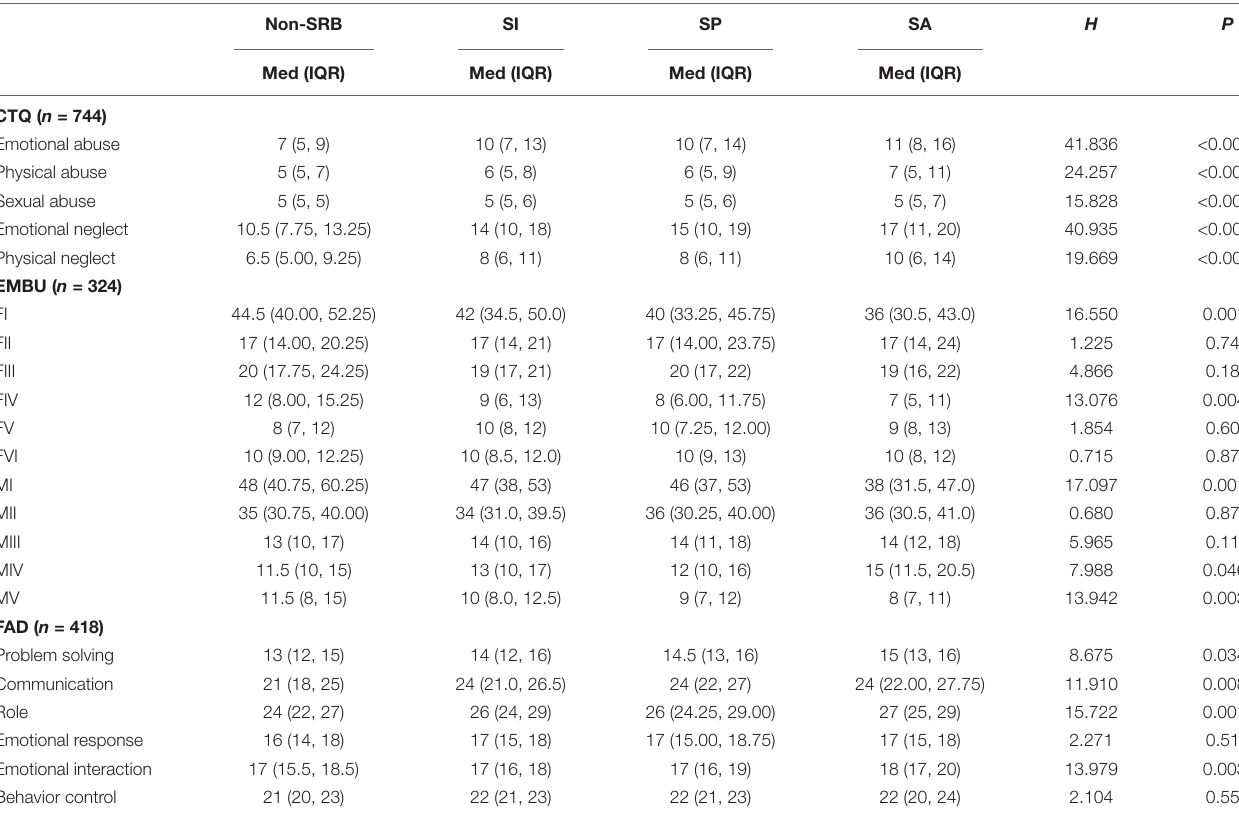
TABLE 1 | Differences in CTQ, EMBU and FAD among the four groups. Non-SRB SI